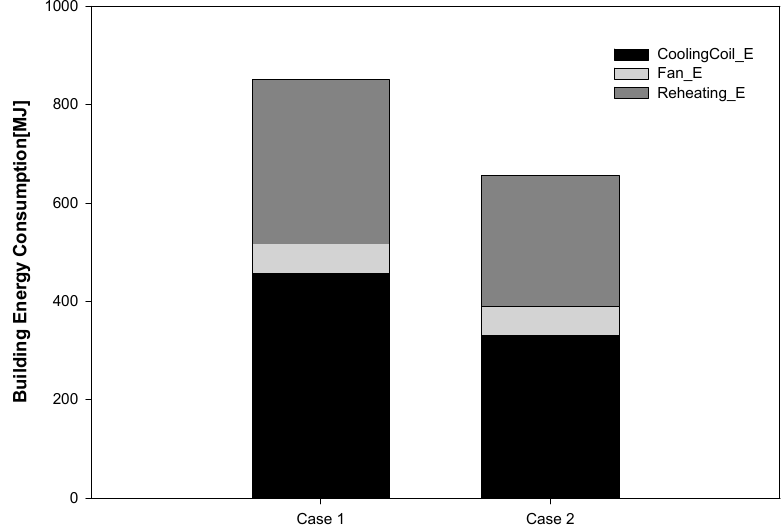
Figure 14. Comparison of the energy requirement according to the energy source.